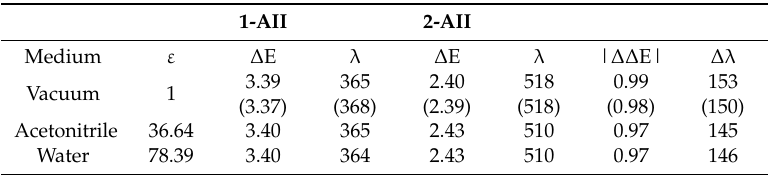
Table 3. The estimated vertical π → π * excitation energies (eV) and wavelength (nm) of 1-AII and 2-AII using the TD-(CAM-B3LYP/6-31G(d)) protocol in different media ( ε is the dielectric constant). The values in parentheses were obtained using the TZVP basis set.